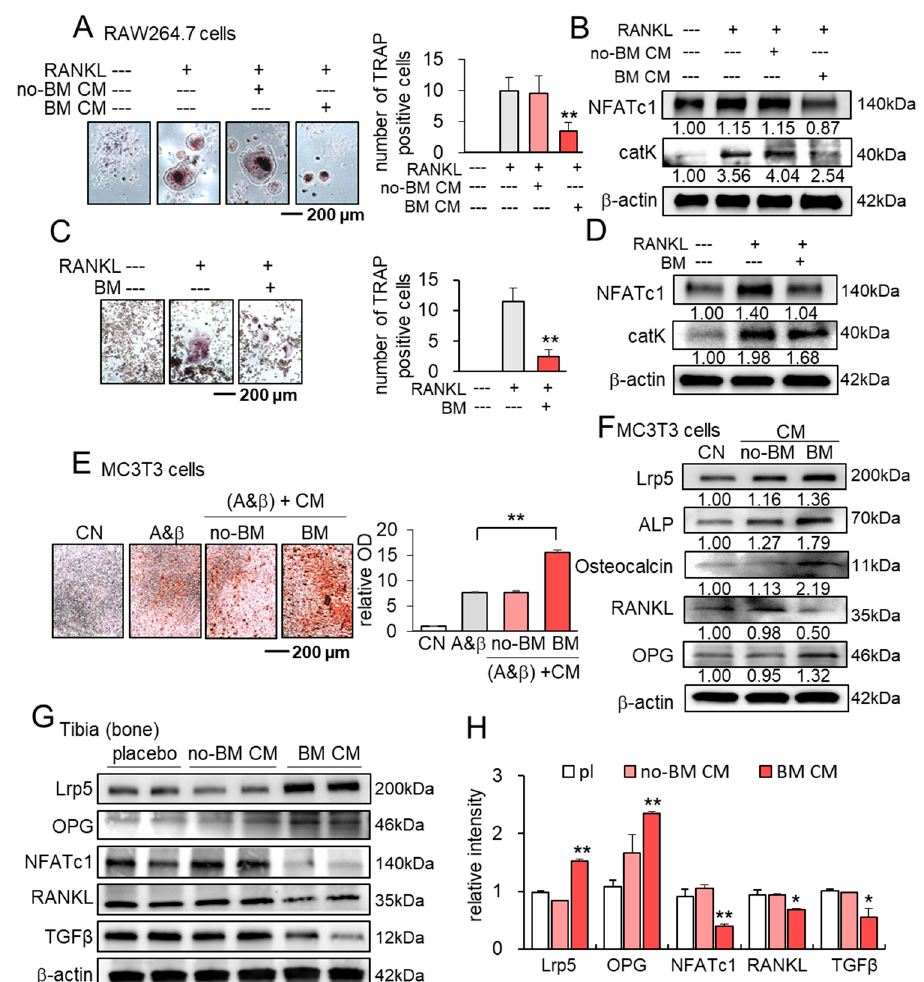
Figure 6. Suppression of osteoclast development and stimulation of osteoblast development by BML-treated RAW CM. CN = control, no-BM CM = RAW-derived conditioned medium treated without BML284, BM CM = BML284-treated RAW-derived conditioned medium, A& β = ascorbic acid (50 µ g/mL) and β -Glycerophosphate (5 mM), and pl = placebo. * p < 0.05 and ** p < 0.01. ( A , B ) Suppression of osteoclast development and downregulation of NFATc1 and cathepsin K by BM CM. ( C , D ) Reduction in osteoclast development and a decrease in NFATc1 and cathepsin K by BM. ( E , F ) Stimulation of osteoblast development and upregulation of Lrp5, ALP (alkaline phosphatase), osteocalcin, and OPG (osteoprotegerin) with downregulation of RANKL in MC3T3 osteoblasts in 4 weeks by BM CM. ( G , H ) Expression of Lrp5, OPG, NFATc1, RANKL, and TGF β in the tibia in response to the 3-week systemic administration of CM with and without BML284 treatment.